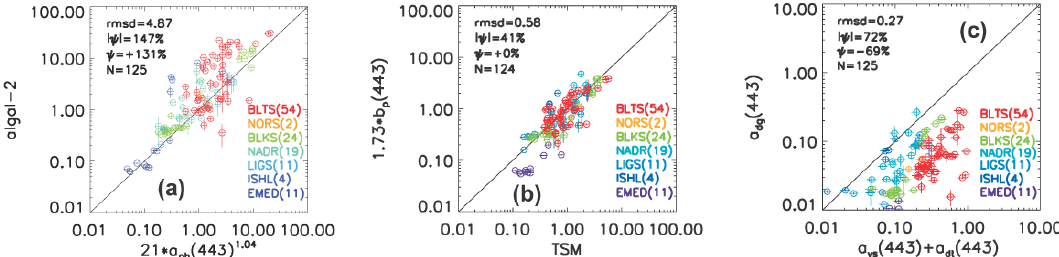
Fig. 6. Scatter plot of: algal-2 pigment index in units of µgL − 1 and equivalent index determined from in situ values of the absorption coefficient of pigmented particles at 443nm, a ph (443) in units of m − 1 (a) ; MERIS TSM values determined from particle scattering at 443nm, b p (443) in units of m − 1 , with respect to in situ gravimetric determinations (TSM) in units of mgL − 1 (b) ; absorption coefficient a dg (443) in units ofm − 1 with respect to combined values of in situ a ys (443) and a dt (443) (c) . All match-ups have been constructed with 1t =± 4h. Different colors identify match-ups from different seas: Baltic Sea (BLTS), North Sea (NORS), Black Sea (BLKS), northern Adriatic Sea (NADR), Ligurian Sea (LIGS), Iberian Shelf (ISHL) and Eastern Mediterranean Sea (EMED).